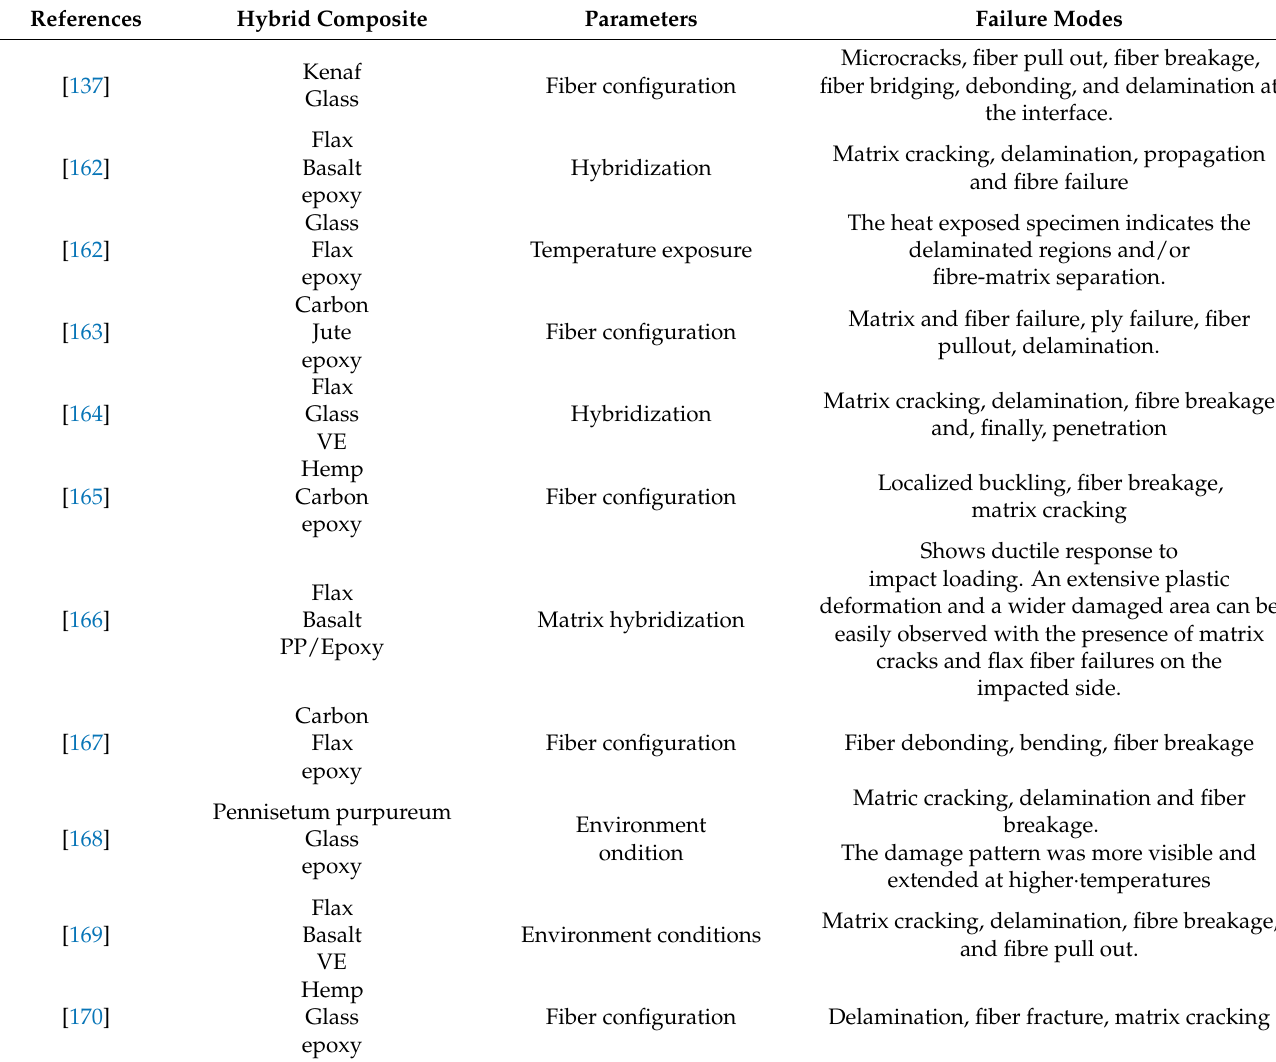
Table 10. Damage caused by impact load of hybrid